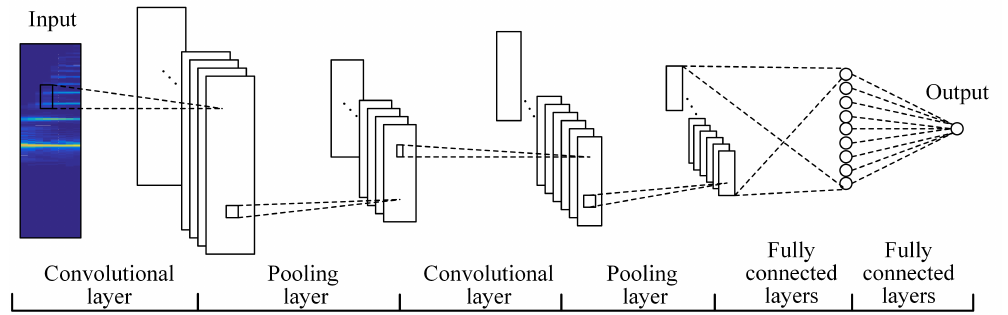
Figure 3. CNN architecture for onset